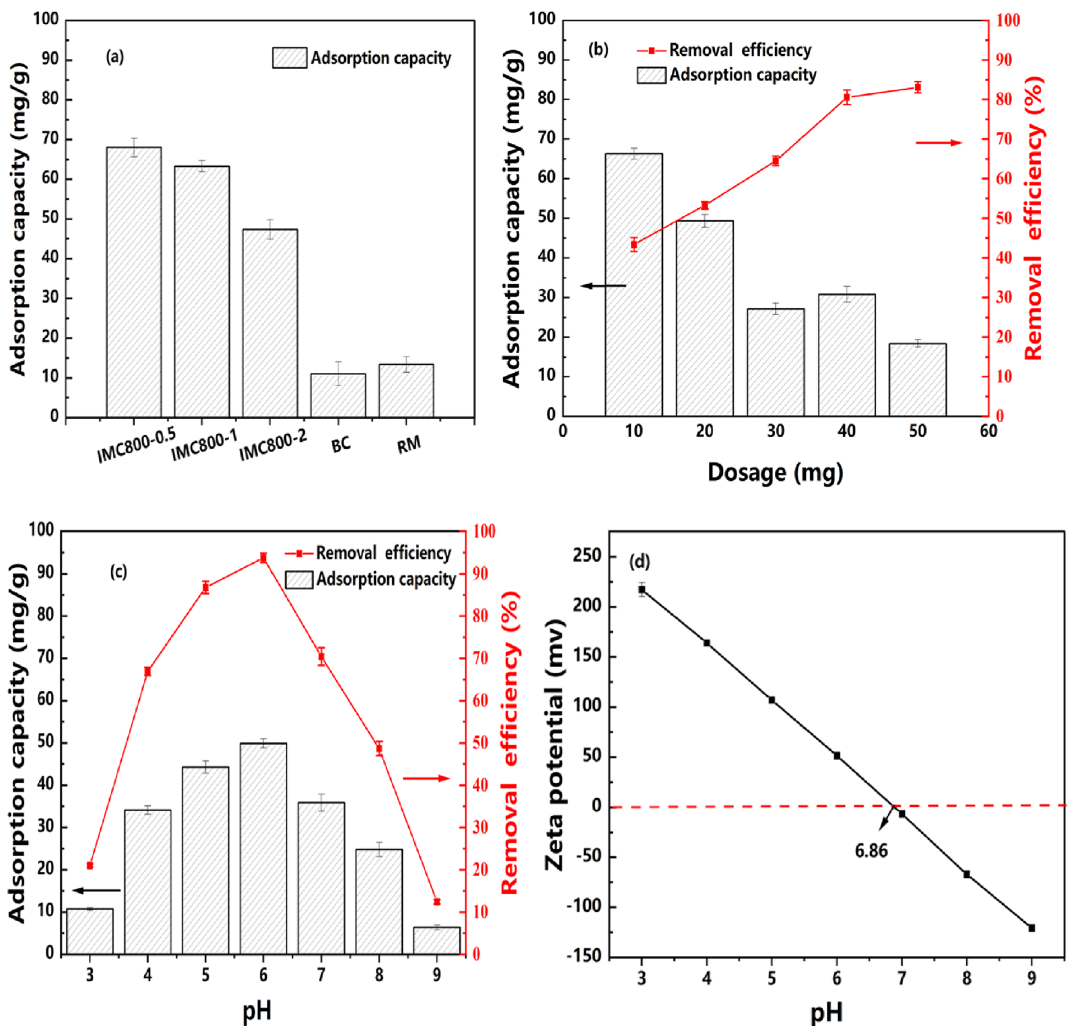
Figure 3. Removal capacity of various IMC materials ( a ), Influence of dosage on removing Cr(VI)of IMC ( b ), pH and Zeta potential determination ( c ), ( d